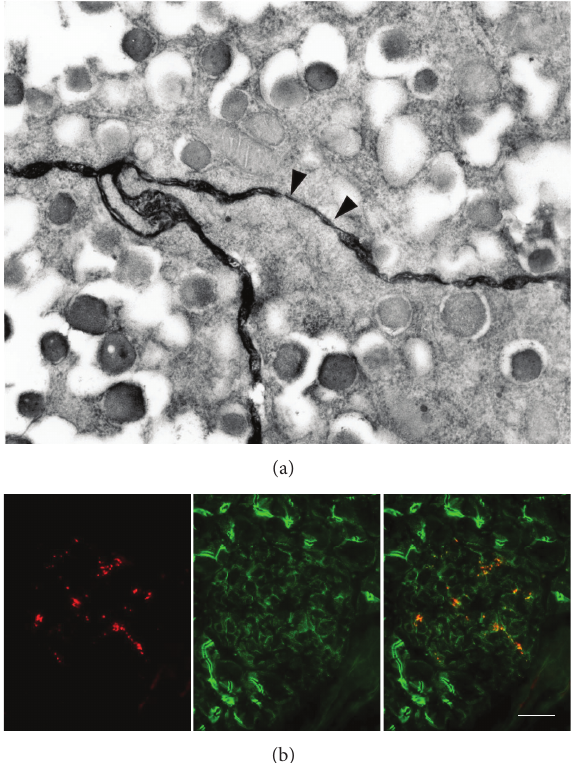
F 4: �ifferent integral proteins have speci�c distributions in the -cell membrane. (a): electron microscopy aer en bloc staining of a pancreatic islet with rhutenium red, shows that the extracellular space between adjacent -cells contains abundant glycosylated cell 𝛽𝛽 adhesion molecule (black), and is markedly narrowed at the site of a gap junction domain (arrow heads) which concentrated connexons. 𝛽𝛽 (b): dual immuno�uorescence of a pancreas section reveals the distribution of E-cadherin (green in midlle and right images) along the membrane of -cells in contact, and of exocrine acini. is wide distribution contrasts with the spotted, discrete distribution of Cx36, which is detected only in the small gap junctional domains of 𝛽𝛽 -cell membranes (red in le image). e right image is the merge of the le and middle images. Bar: 250nm in (a), and 50 m in 𝛽𝛽 𝜇𝜇